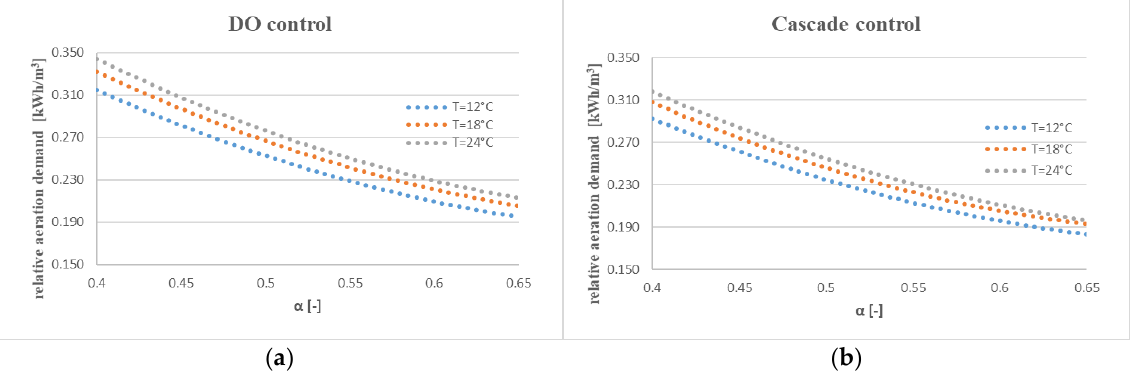
Figure 3. Relative aeration demand as a function of the alpha ( a ) DO control and ( b ) cascade